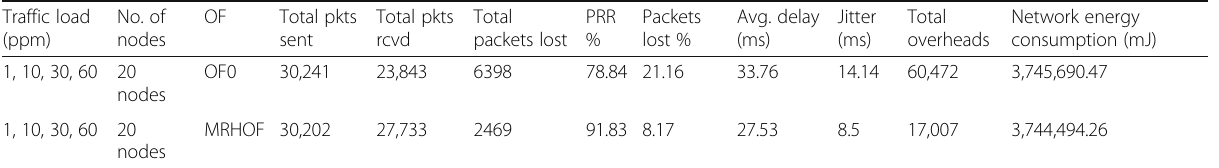
Table 2 ContikiRPL analysis of heterogeneous traffic load scenarios with OF0 and MRHOF Traffic load (ppm)